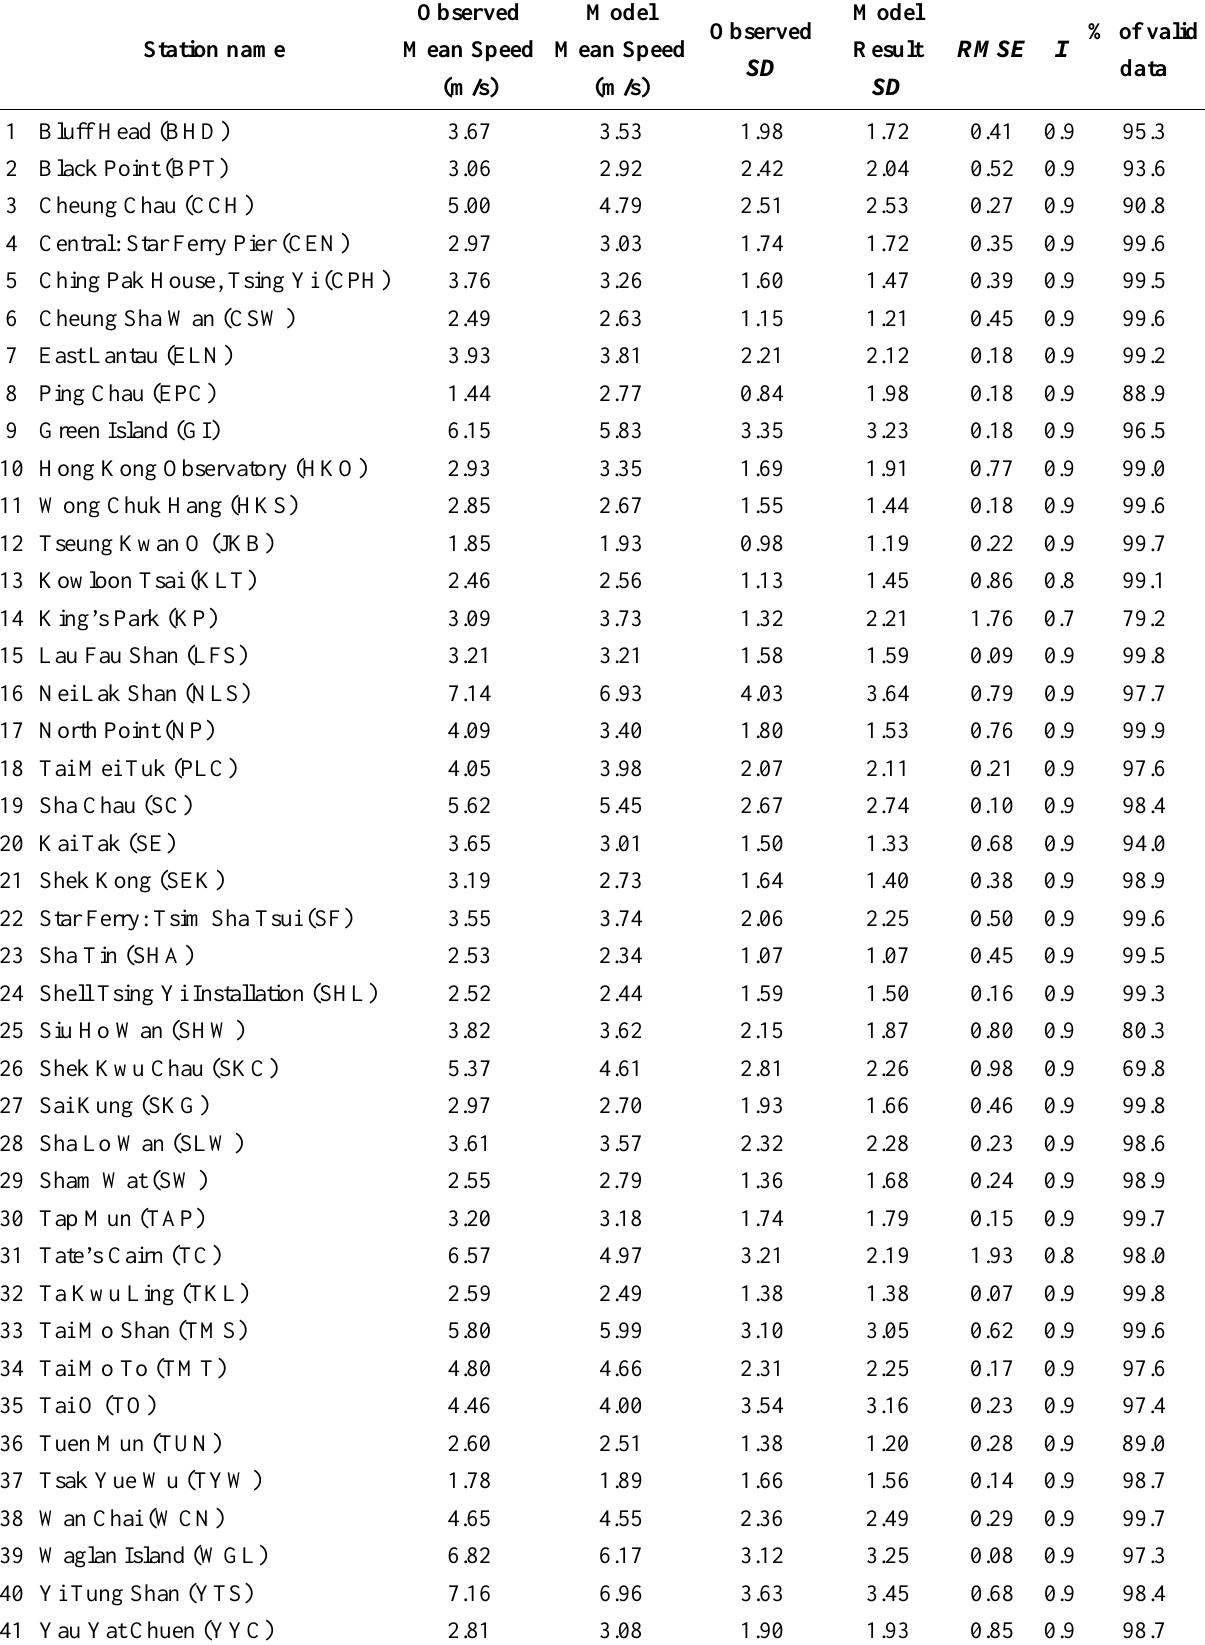
Table 1. The statistical results of 41 included meteorological surface